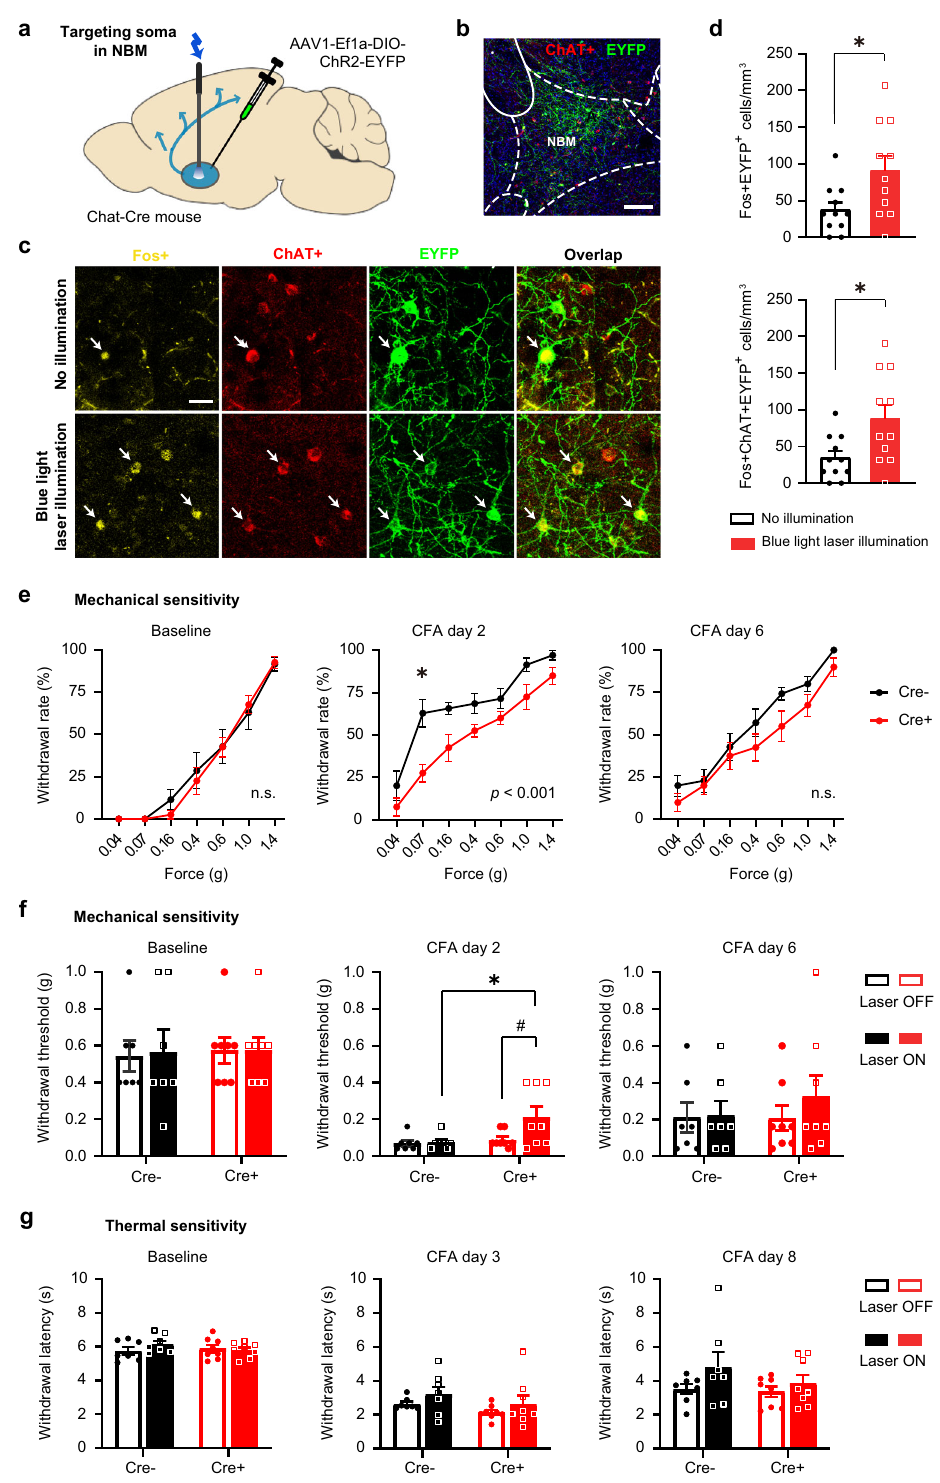
Fig. 4 | Optogenetic activation of the NBM cholinergic neurons attenuates in fl ammatory mechanical, but not thermal, hypersensitivity. a Scheme for optogenetically manipulating NBM cholinergic neurons with blue laser light. b – d Expression oftheexcitatoryopsin, Channelrhodopsin-EYFPinthe NBM ( b ), typical examples( c )and quanti fi cation ( d )ofenhancedFos expression in EYFP+ and ChAT+ neurons (arrows in c ) with blue light, thus validating the ef fi cacy of optogenetic activation in vivo. n =3 mice/group; * P <0.05 (0.0234, top; 0.0183, bottom), unpaired two-tailed t test. Scale bar=200 µ m in b and 25 µ m in c .